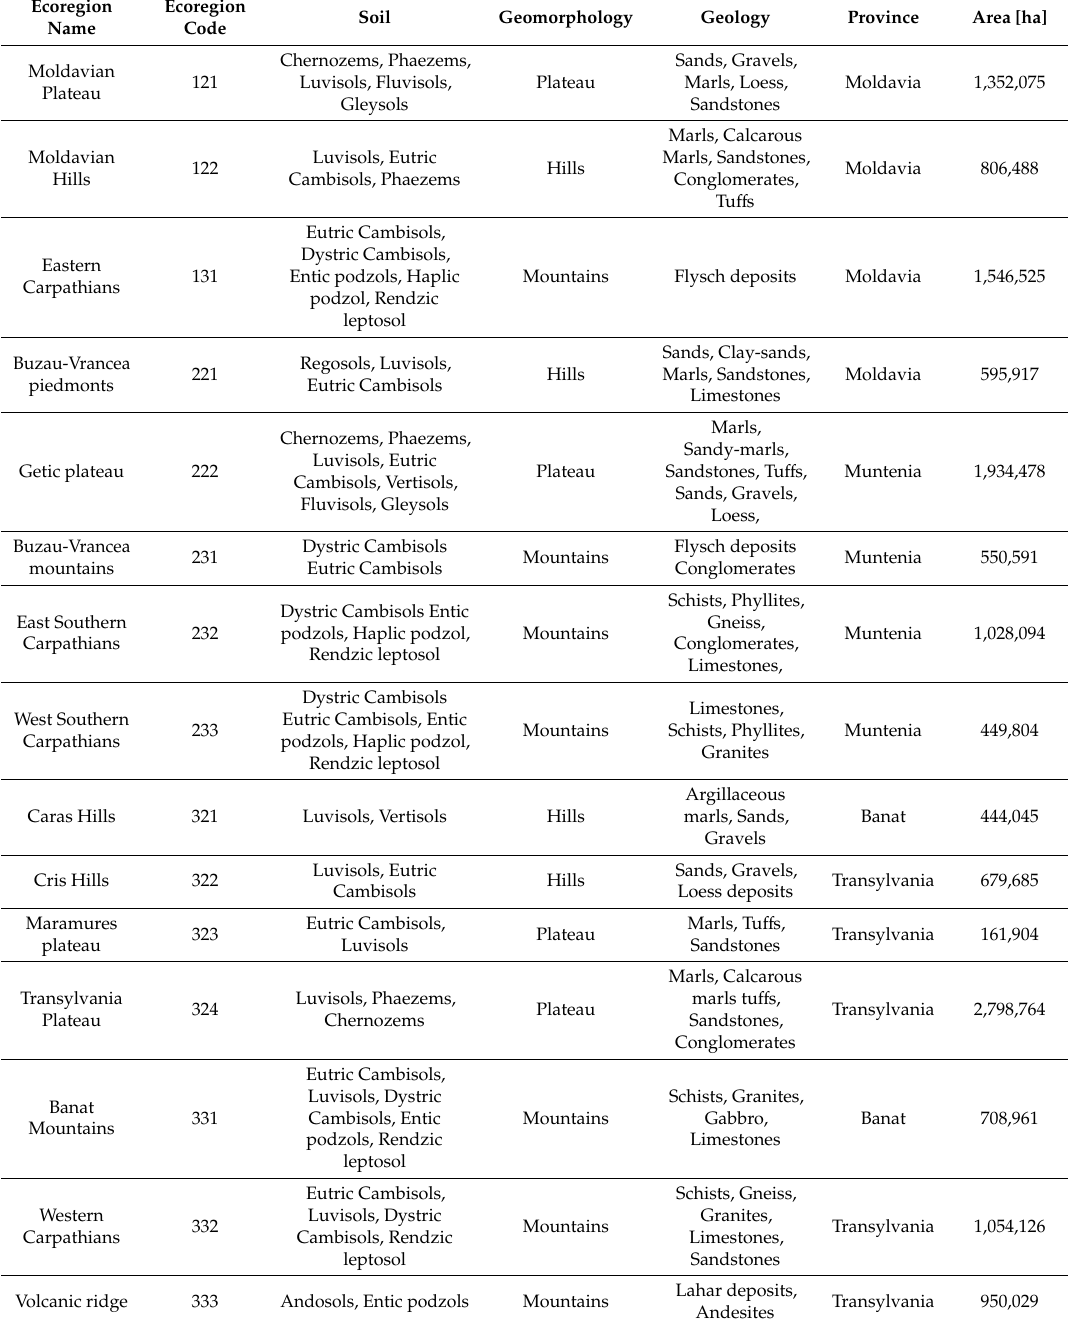
Table 1. Romanian Ecoregions for which the growth of Norway spruce, European beech or Sessile oak was analyzed